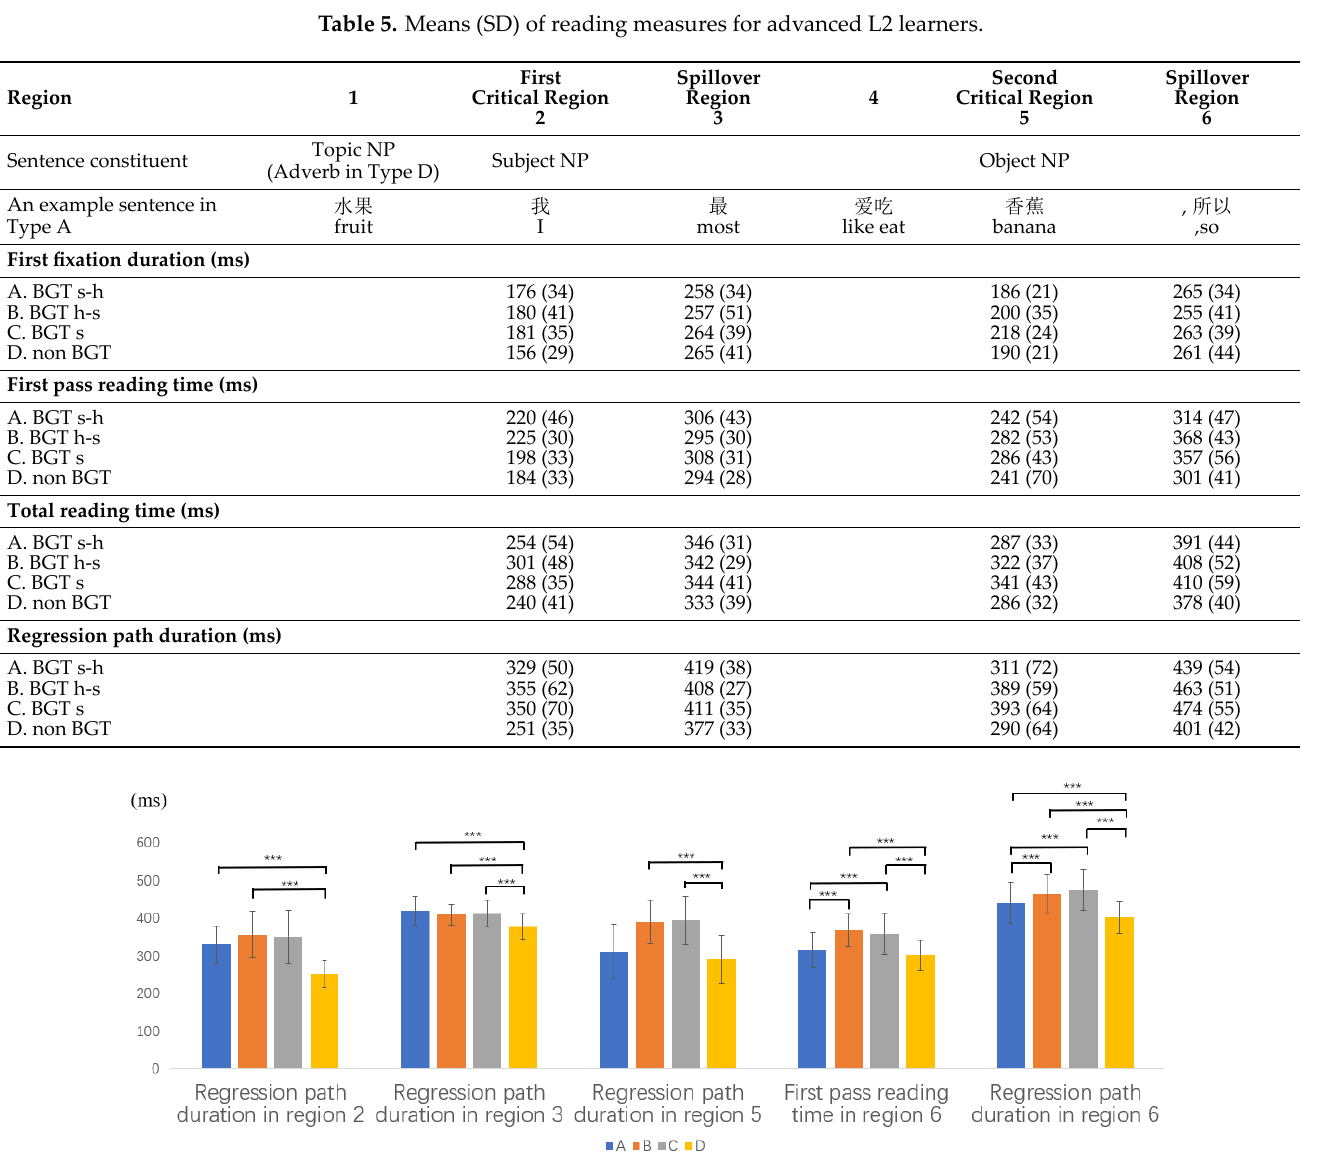
Figure 3. Part of representative reading measures for advanced L2 learners (*** p < 0.001).